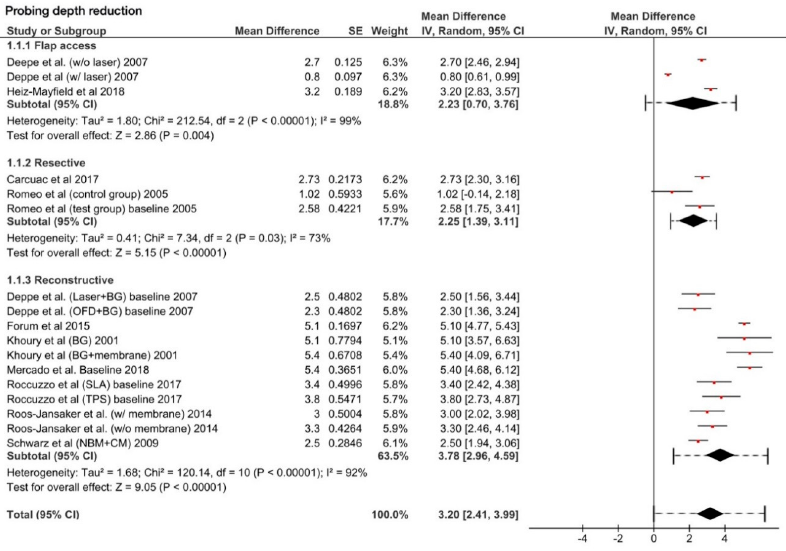
Figure 3. Probing depth reduction after treatment of peri-implantitis following flap access, resective or reconstructive approaches. Mean probing depth reduction in each study is reported by a red dot. The 95% confidence intervals are indicated with horizontal lines intersecting the mean probing depth reduction. The estimate average and confidence interval of all the individual studies are reported with black diamonds. Prediction intervals are reported as dotted lines intersecting the diamonds. A diamond on the right of the line of null effect indicates probing depth reduction and a diamond on the left of the line of null effect indicates probing depth increase. Abbreviations. BG: bone grafting, CM: collagen membrane, OFD: open flap debridement, SLA: sandblasted acid-etched surface, TPS: titanium plasma-sprayed surface.